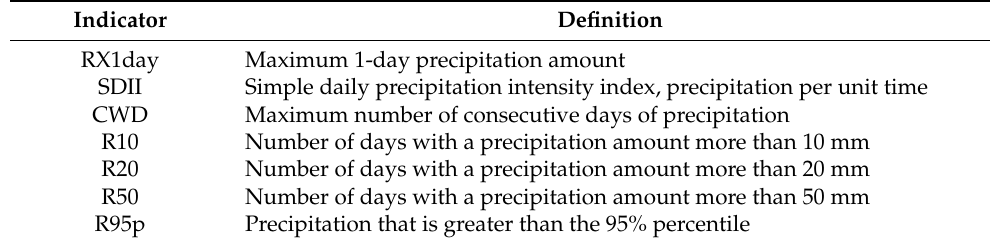
Table 3. Extreme precipitation indicators.